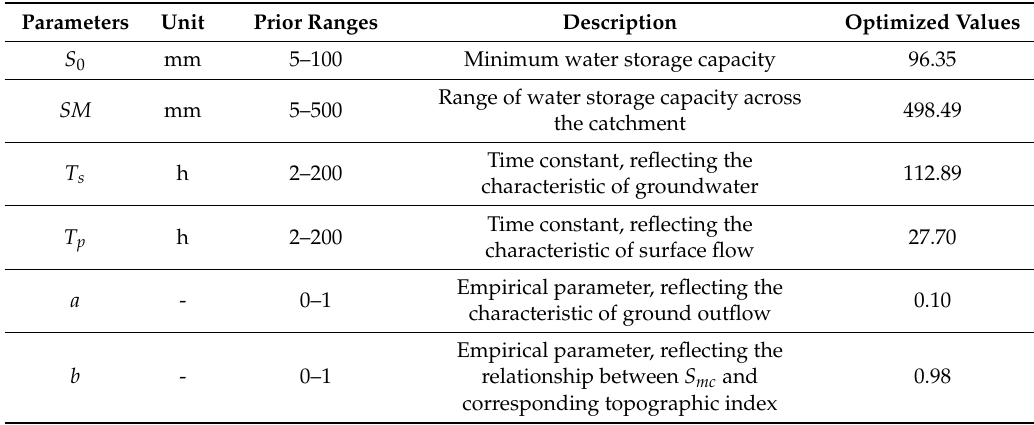
Table 3. Descriptions of the DDRM